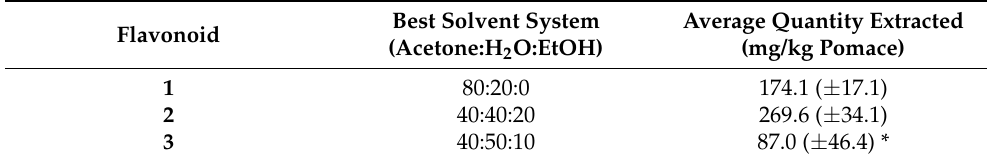
Table 3. Solvent systems that had extracted the highest amount of each flavonoid and the average (of triplicate extractions) quantity (mg/kg pomace) as measured in the